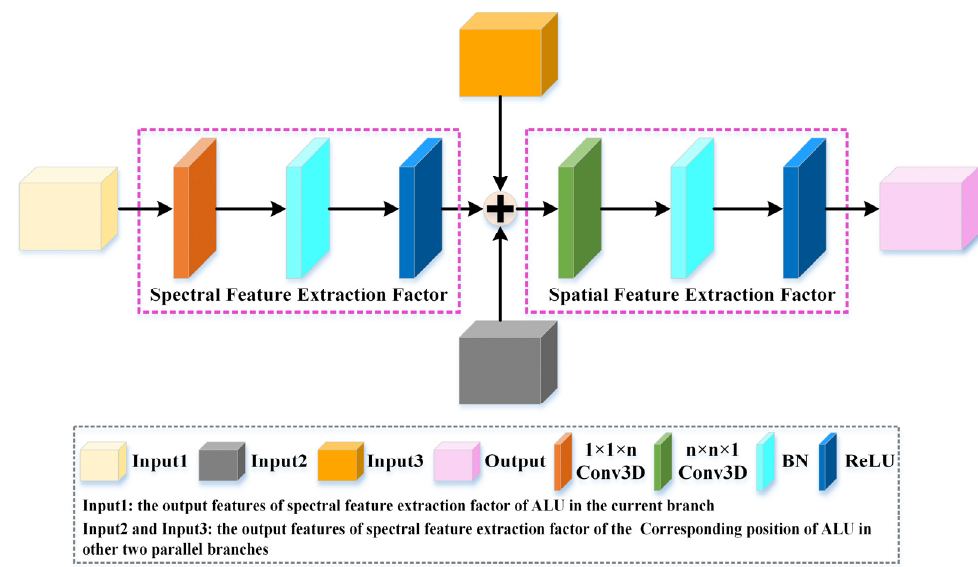
Figure 2. The structure diagram of additive link unit (ALU).